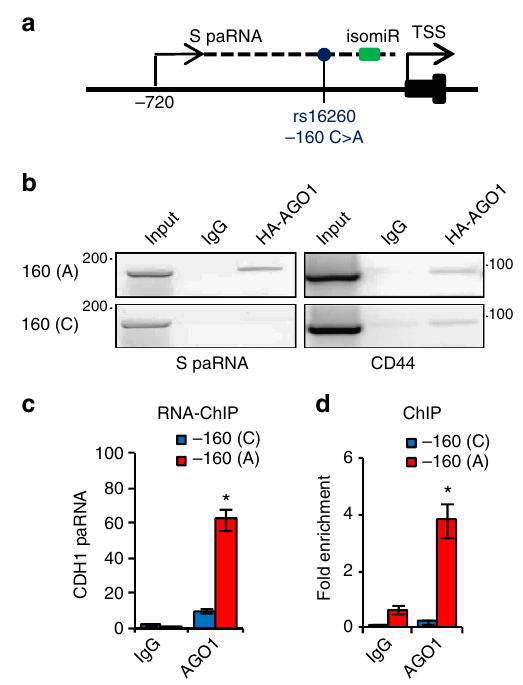
Figure 6 | SNP rs16260 affects binding of Argonaute 1 to sense promoter-associated RNA. ( a ) Position of SNP rs16260 (blue circle) and isomiR-4534 binding site (green rectangle) in the CDH1 promoter. ( b ) Allele-specific binding of HA-AGO1 to the (cid:2) 160A and (cid:2) 160C S-paRNA determined by RIP. CD44 mRNA, positive control. ( c ) Allele-specific binding of endogenous AGO1 to the 160A and (cid:2) 160C S-paRNA determined by RNA-ChIP. ( d ) Allele-specific binding of AGO1 to the CDH1 promoter with either the 160A and (cid:2) 160C allele determined by ChIP. Data are mean ± s.d. of three independent determinations. Student’s t -test was used for P value assessment. * P o